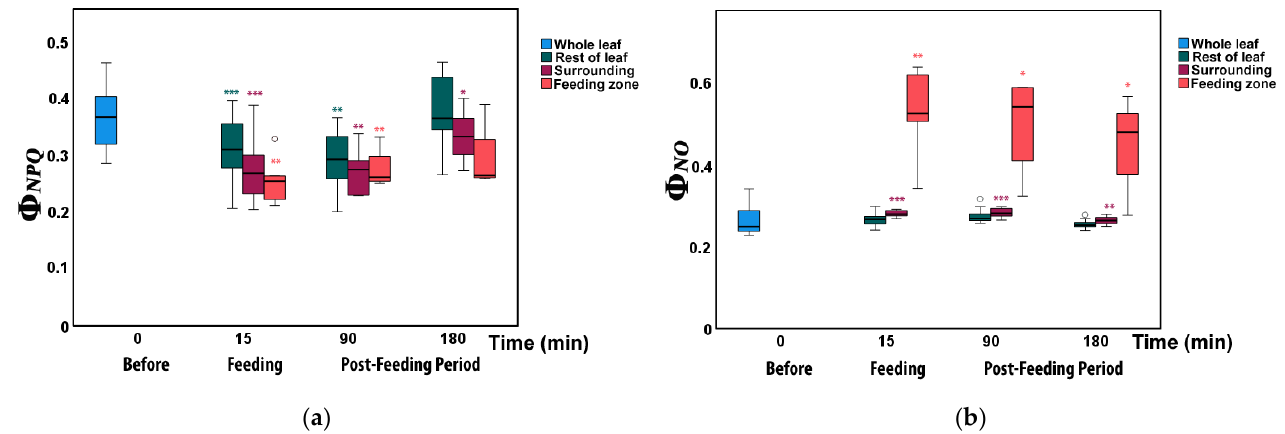
Figure 4. Changes in PSII quantum yield of ( a ) regulated non-photochemical energy loss ( Φ NPQ ) and ( b ) non-regulated energy loss ( Φ NO ) in different zones of tomato leaflets before (0 min), immediately after (15 min), and post-feeding period, 90 and 180 min after insect feeding. Symbols, box plots, and significances are as in Figure 3.